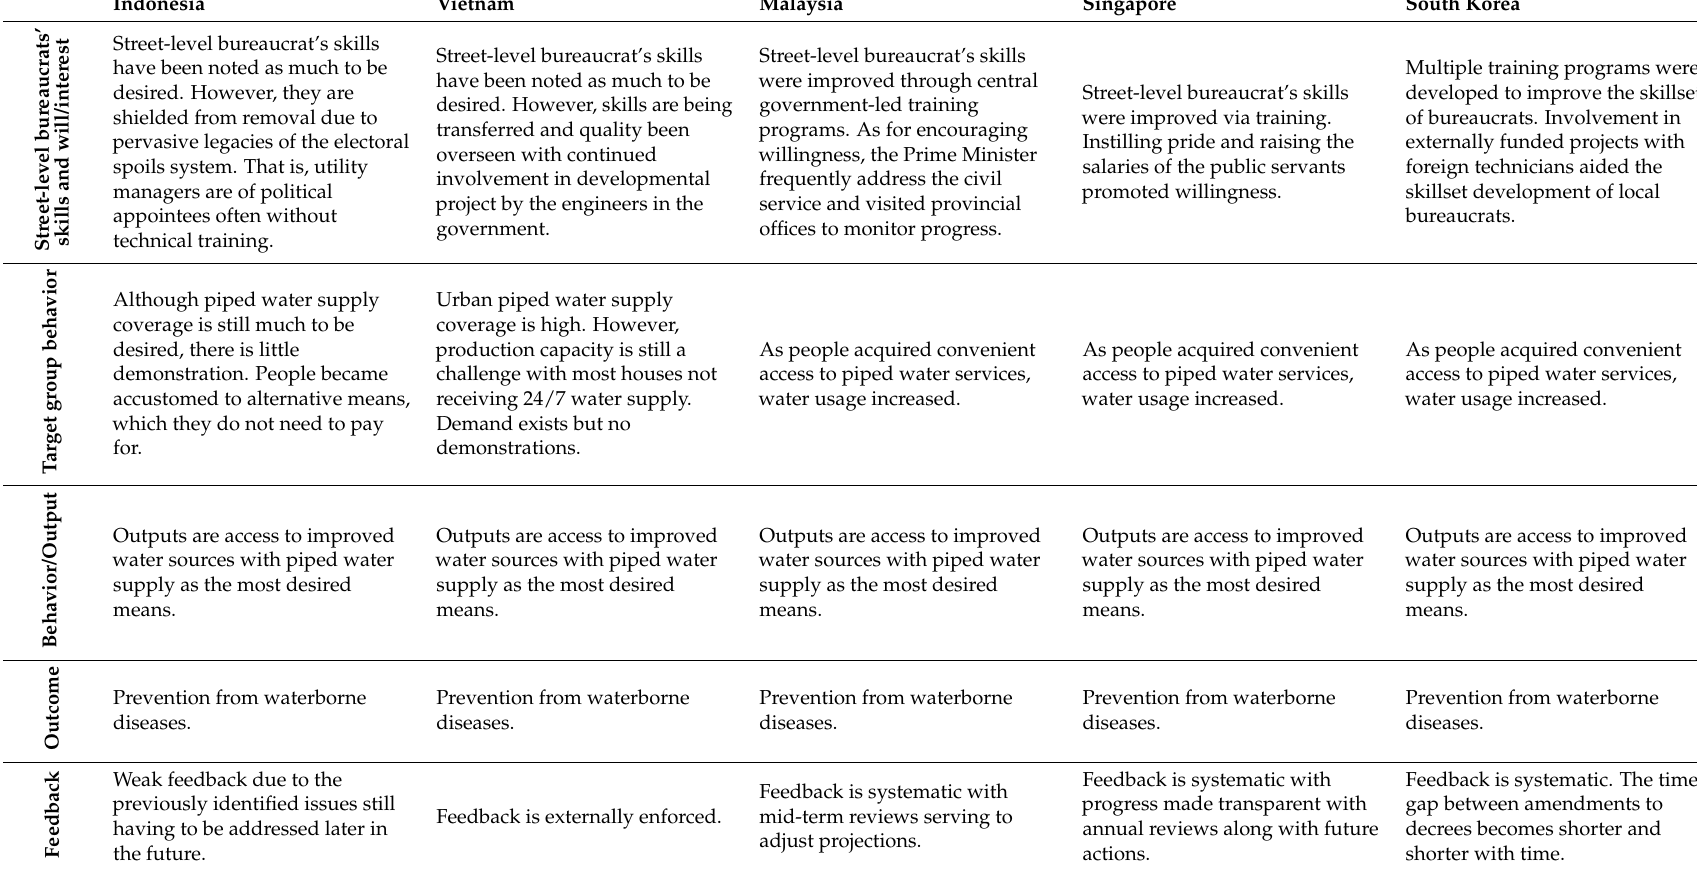
Table 2. Fitting the Case Studies in the Integrated Implementation